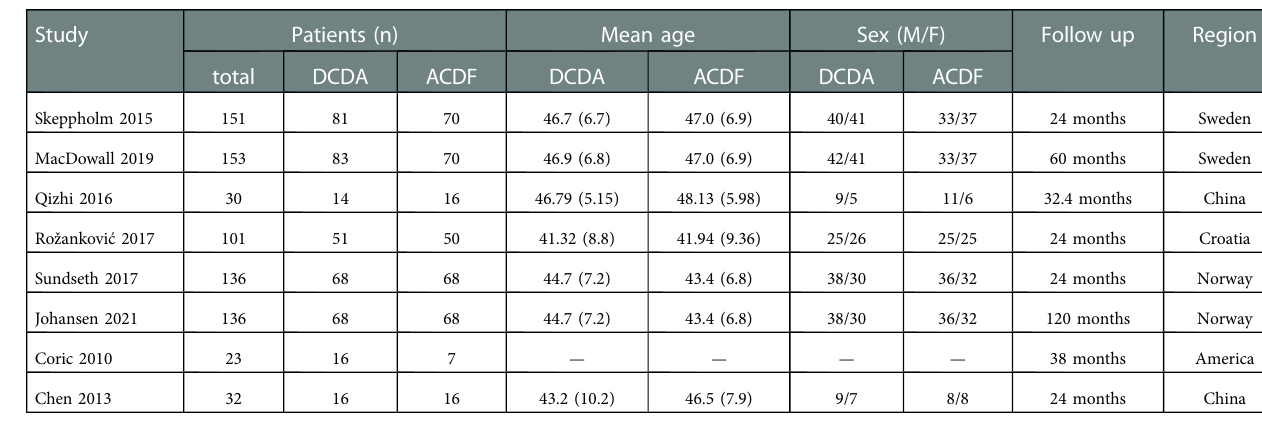
TABLE 1 Characteristics of included studies.